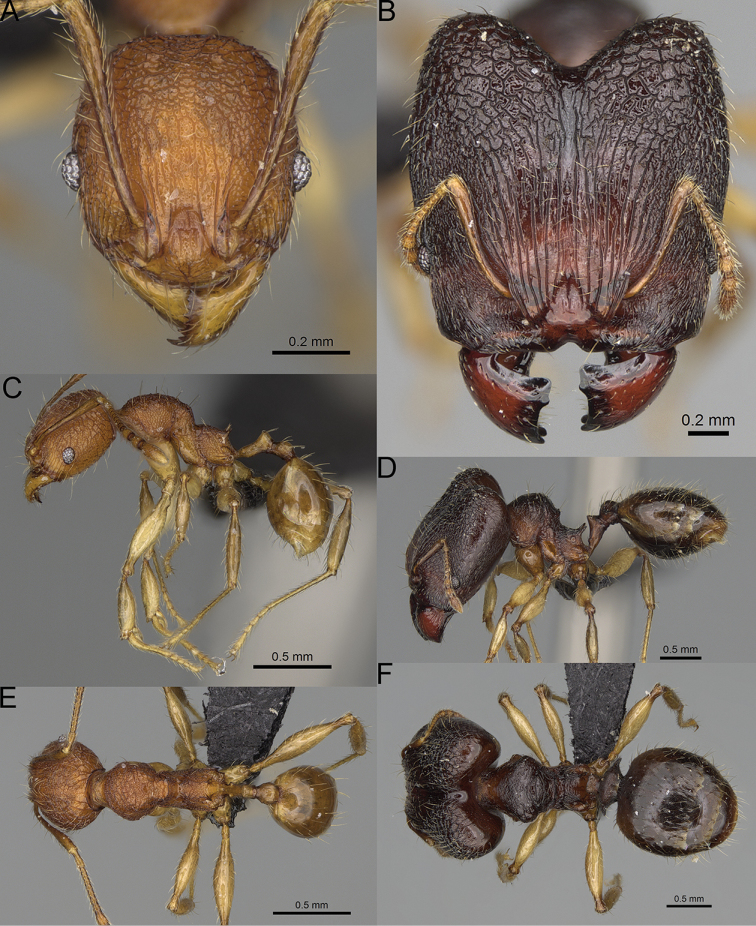
Pheidole
curvistriata sp. nov., full-face view (A), profile (C), and dorsal view (E) of paratype minor worker (CASENT0492901) and full-face view (B), profile (D), and dorsal view (F) of holotype major worker (CASENT0492904).